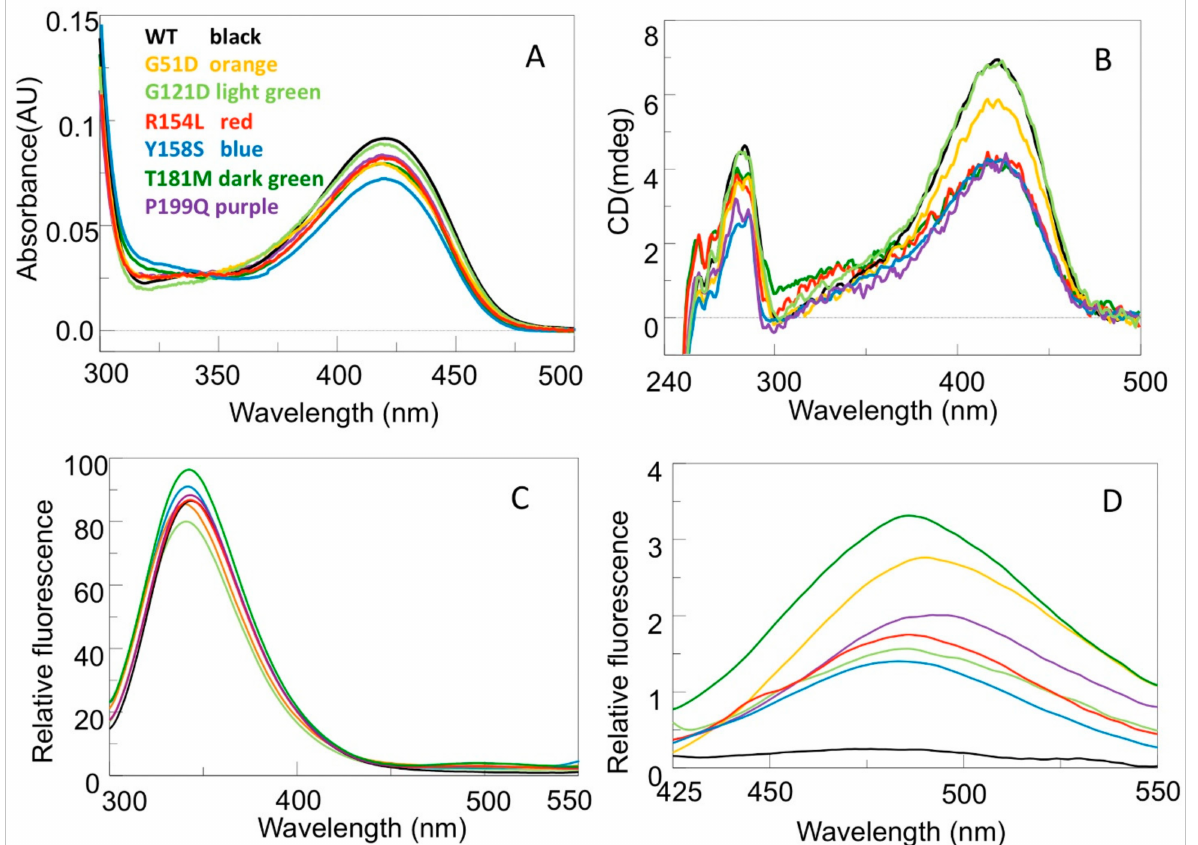
Figure 4. Spectroscopic analysis of the interface pathogenic variants of hOAT. ( A ) Absorption spectra and ( B ) nearUV-vis CD spectra of 6 µ M enzyme in Hepes 50 mM pH 8.0, NaCl 150 mM. ( C ) Intrinsic fluorescence emission spectra of 1 µ M enzyme upon excitation at 280 nm. ( D ) ANS fluorescence emission spectra of 1 µ M enzyme upon excitation at 367 nm. Both intrinsic fluorescence and ANS fluorescence emission spectra were registered in Hepes 50 mM pH 8.0, NaCl 150 mM. All the CD and fluorescence spectra were registered in the presence of 10 µ M exogenous PLP. All the panels share the indicated color